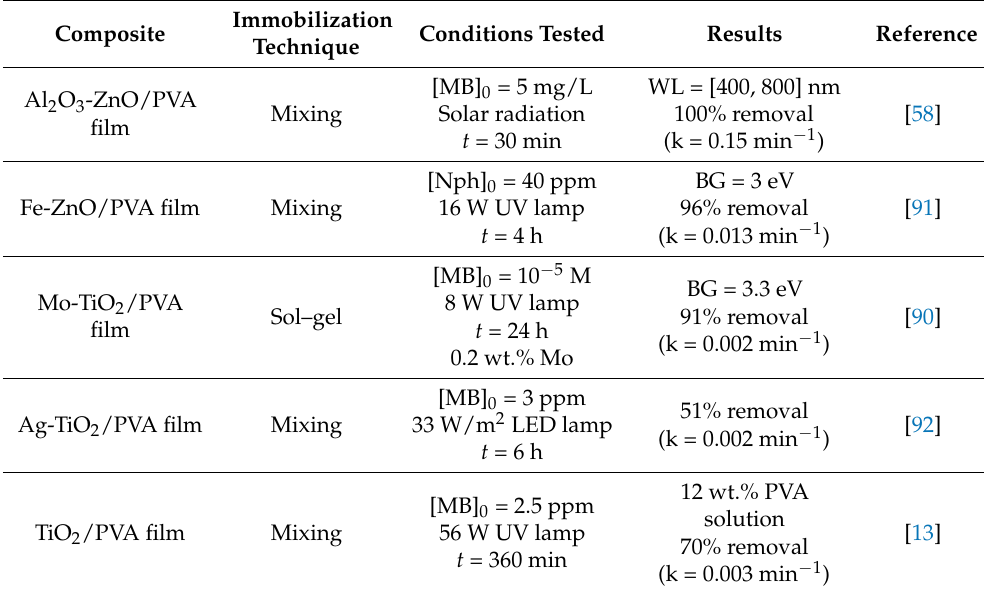
Table 12. Summary of studies that have analyzed the effect of doping the catalyst on the PVA- supported photocatalysis process.